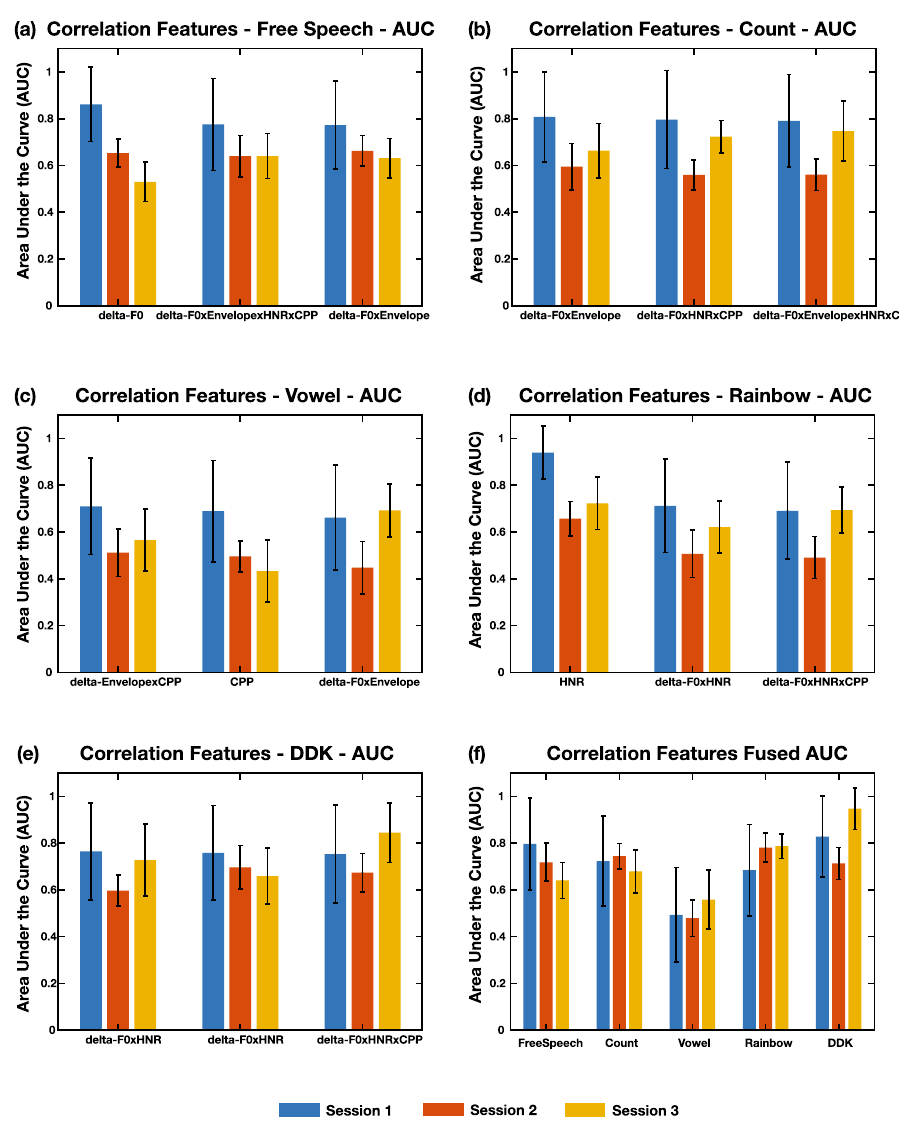
Figure 3. Top correlation-based features’ AUCs across tasks and fused model performance. ( a – e ) AUC scores across prediction of three different days for the top three performing features in each of the five. The features appear to be most commonly from the laryngeal subsystem. HNR during the Rainbow task has the highest AUC at 0.94. ( f ) AUC scores from models created by fusing across all models created from the correlation based features. There is a decrease seen in performance relative to the top feature in the Free Speech, Count, Vowel, and Rainbow tasks, and an increase in performance relative to the top feature seen in the DDK task. Error bars are the standard deviation of the statistic across all bootstrap